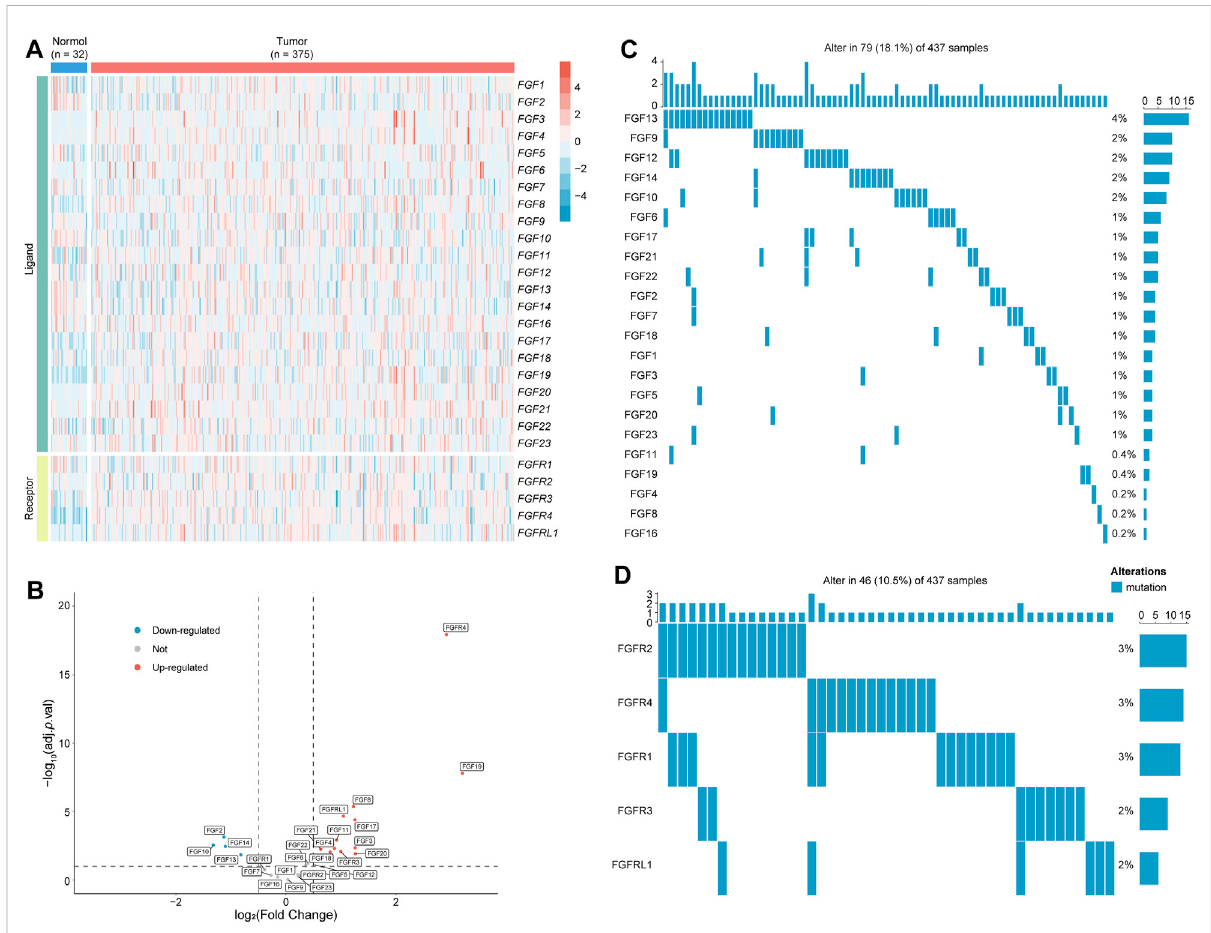
FIGURE 2 TheexpressionandmutationofFGF/FGFRinGC. (A,B) TheexpressionofFGF/FGFRfamilymembersinnormalandGCtumortissueswasshown in heatmap (A) and volcano plot (B) . (C) The mutation rate of FGFs in GC. (D) The mutation rate of FGFRs in GC. FGF, fi broblast growth factor; FGFR, fi broblast growth factor receptor; GC, gastric